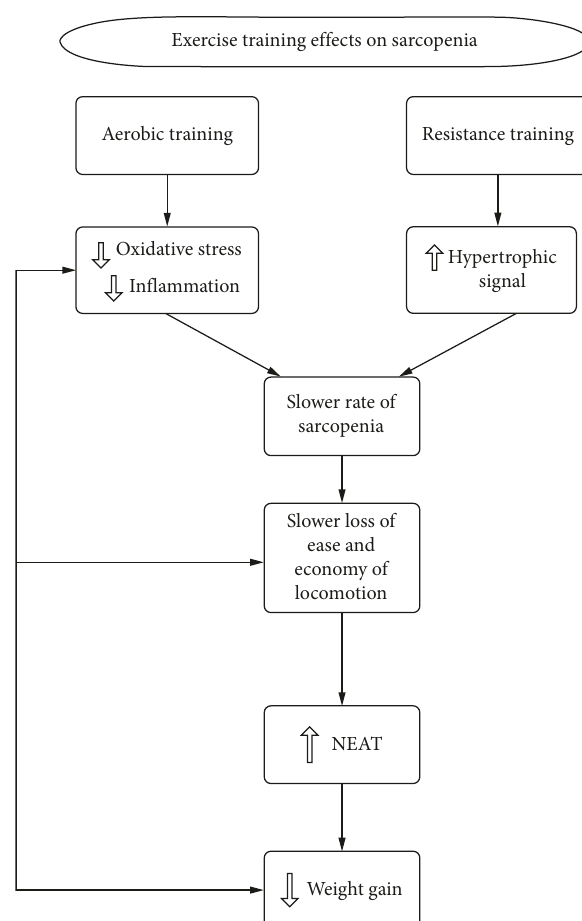
Figure 3: Exercise training effects on